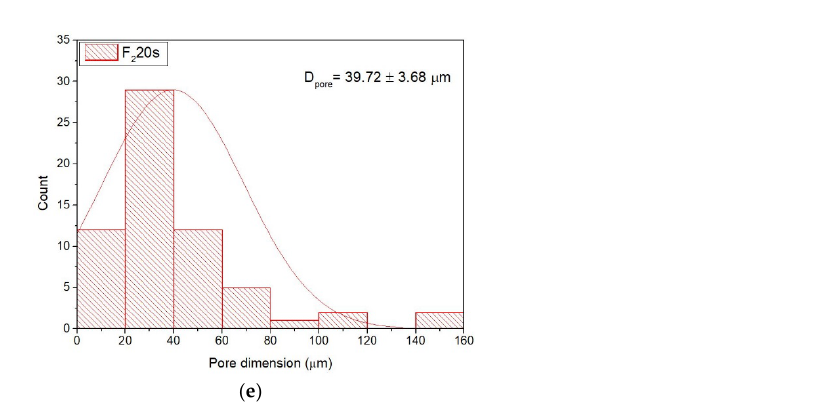
Figure 6. EDS spectra for F 2 ( a ) and F 2 20s ( b ) samples.